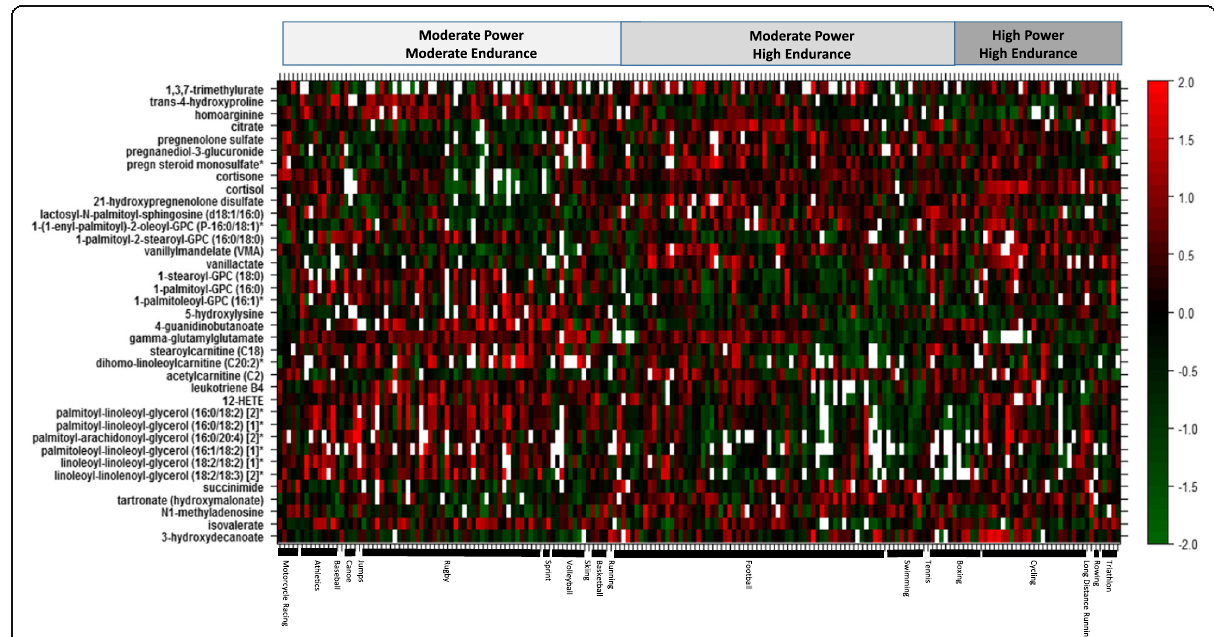
FDR correction (Additional file 2: Table S7). As for power, 144 metabolites were differently associated with power between males and females, among which 35 me- tabolites remained significant after FDR correction (Additional file 2: Table S8).